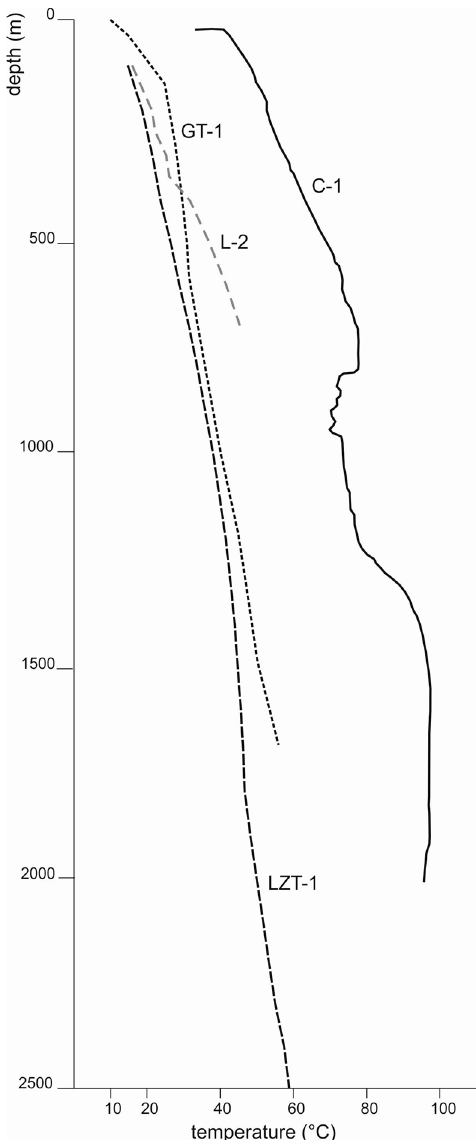
Figure 4. Temperature profiles in particular wells in the Sudetic region (based on [20,47,49,54]. According to results obtained by Bruszewska [62], the average geothermal gradient in the areas of Duszniki-Zdr ó j and L ˛adek-Zdr ó j ranges from 2.3 to 3.0 ◦ C/100 m, with temper- atures at a depth of 1500 m in the ranges of 44–46 ◦ C and 40–42 ◦ C, respectively. During the drilling of well GT-1 in Duszniki-Zdr ó j, a temperature of 55.8 ◦ C was observed at a